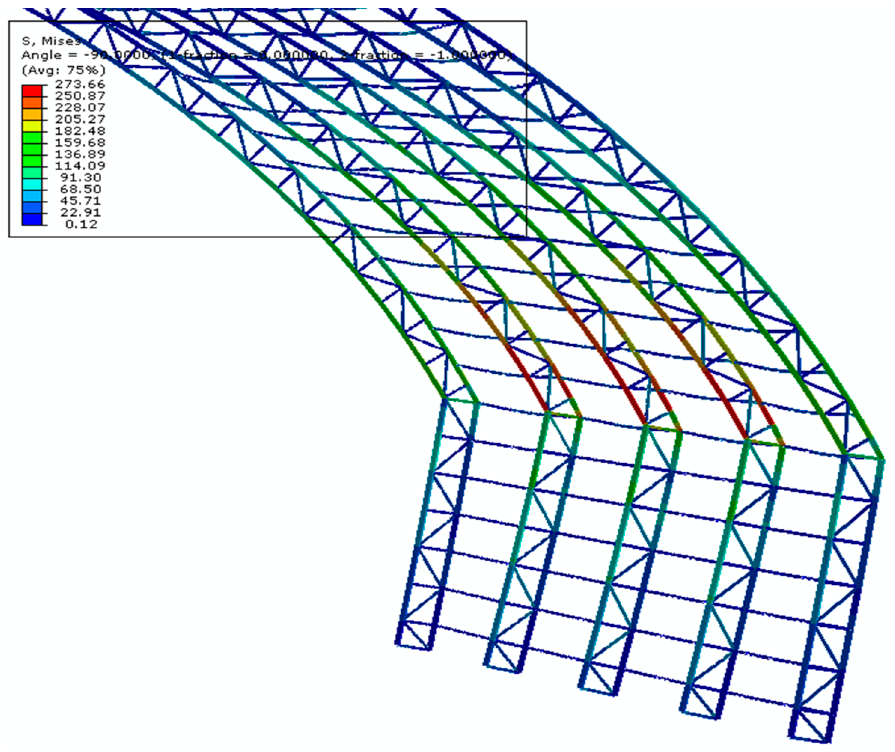
Figure 14. The Von–Mises stress distributions in Model 2 with two supports. Table 3. The maximum vertical displacements for different FE models (units in mm). Table 2. The maximum Von–Mises stresses for di ff erent FE models (units in MPa). Four Supports Three Supports Two Supports